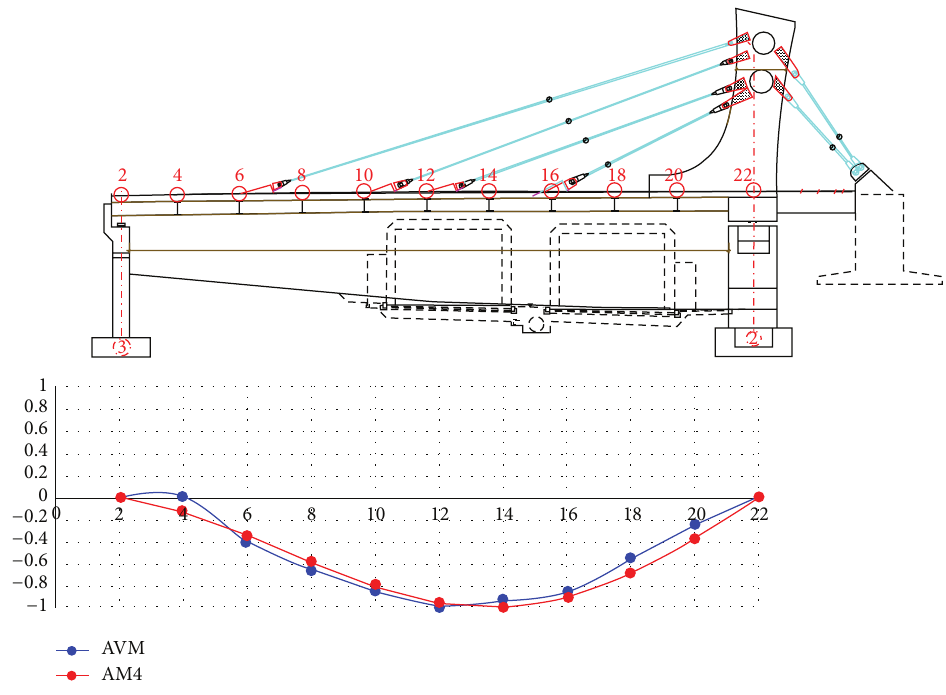
Figure 35: Experimentally and mathematically identified first mode shapes.